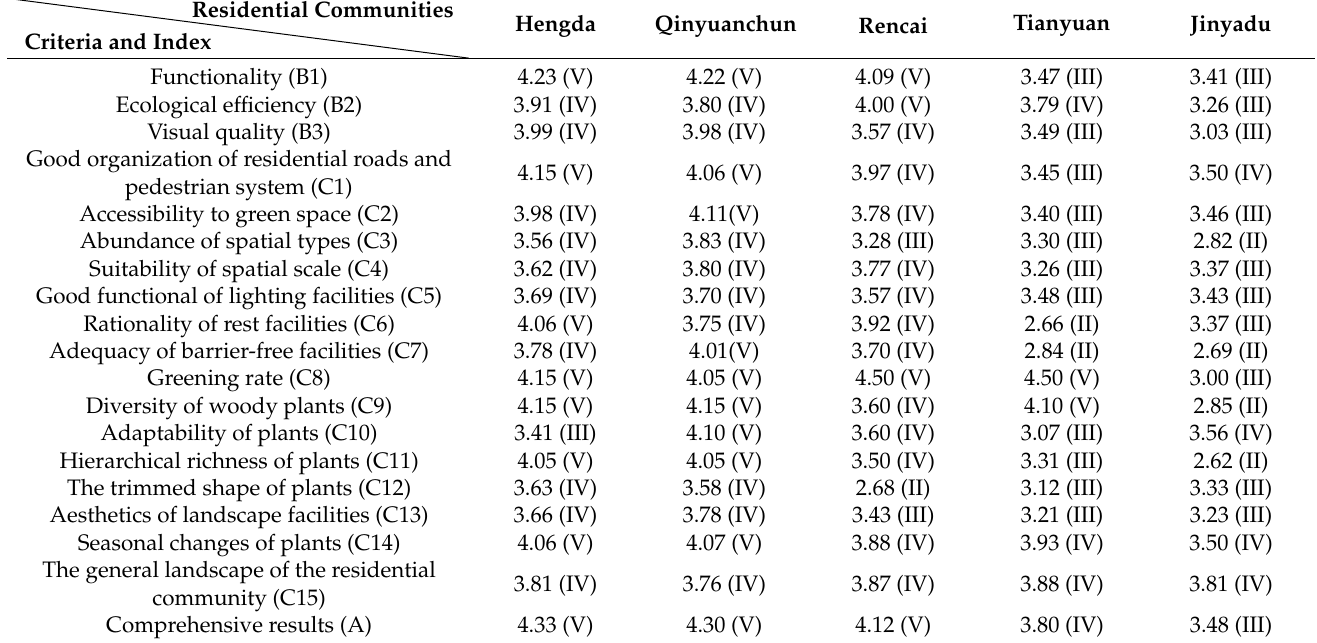
Table 2. Landscape evaluation of residential communities scored by